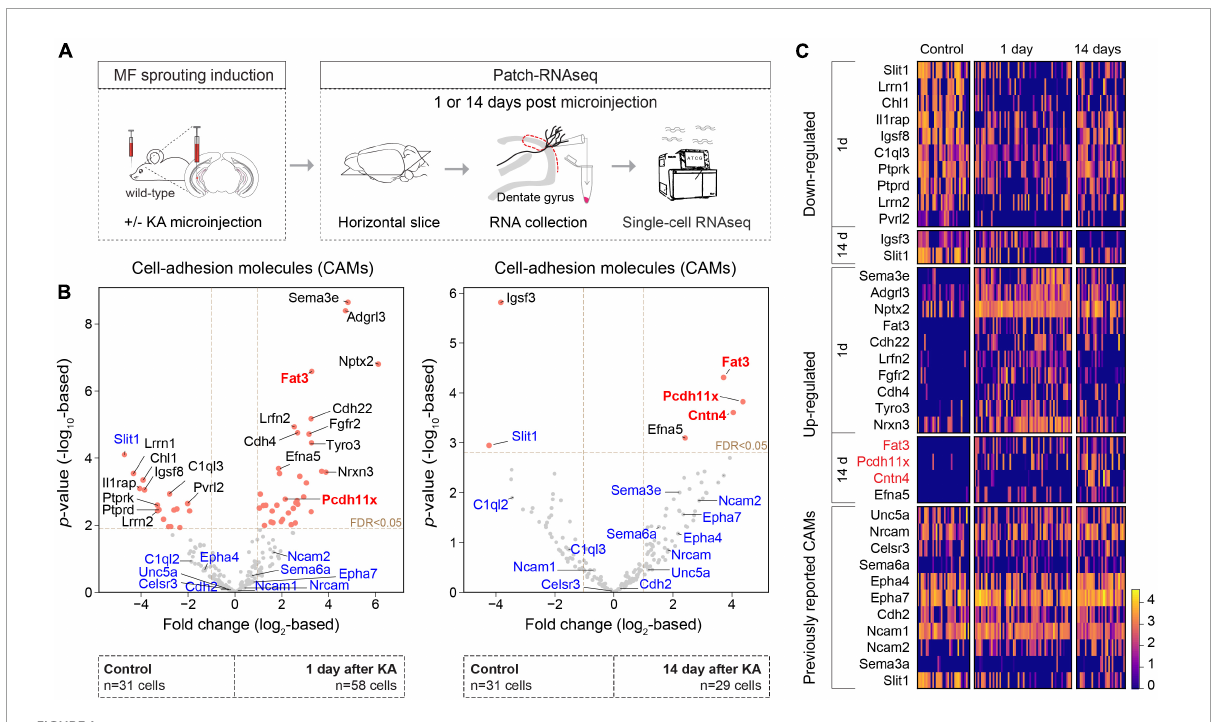
FIGURE1 CAM expression changes during MF sprouting. (A) Experimental design and schedules used for generating the single-cell RNAseq dataset (Luo et al., 2021; GSE 161619). (B) Volcano plots show differentially expressed CAMs in GC 1 (left panel) and 14 days (right panel) after intrahippocampal KA injection compared to controls. Red points denote differentially expressed genes (FDR < 0.05 and fold change > 2). Gene names highlighted with blue were previously reported in epilepsy and/or MF sprouting models (see section “Discussion”). Gene names highlighted with red were shortlisted for further analysis in this study. (C) Heat map of top 10 differentially expressed genes and genes/molecules previously reported in epilepsy and/or MF sprouting models. Scale bar shows log2-normalized gene expression